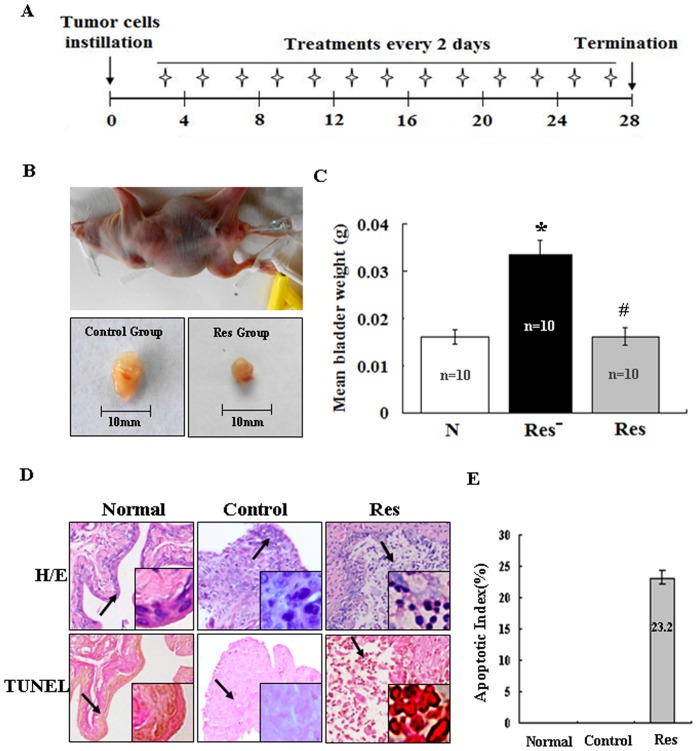
Growth inhibition and apoptosis induction of mouse orthotopic bladder tumors by 2 µM resveratrol intravesical instillation for 13 times in 2 day intervals.A. Schematic diagram of study design and dosing schedule. Treatments began 3 days after implantation (asterisks). B. Upper: Urethral catheterization of nude mice; Lower: the sizes of a pair of tumor-bearing urinary bladders without and with 2 h 200 µM resveratrol intravesical instillation for 13 times. C. Comparison of tumor burdens between resveratrol instillation group and the untreated control at Day 28 after tumor implantation. Normal nude mice (the same weeks old) bladders free of tumor implantation as control. *, compared with N group or Res group, P<0.01; #, compared with N group, P>0.05. D. H&E staining and TUNEL assay (the insets) for histological and apoptosis evaluation of urinary bladder tissues with intravesical resveratrol treatment (2 h 200 µM resveratrol for 13 times in 2 day intervals). Normal: the bladder of a nude mouse; Control: the bladder bearing orthotopic transplanted tumor without resveratrol treatment (0.9% NaCl treatment); Res: the bladder bearing orthotopic transplanted tumor with 200 µM resveratrol treatment for 2 h and 13 times. E. Evaluation of apoptotic indexes among Normal, Control and Res groups.